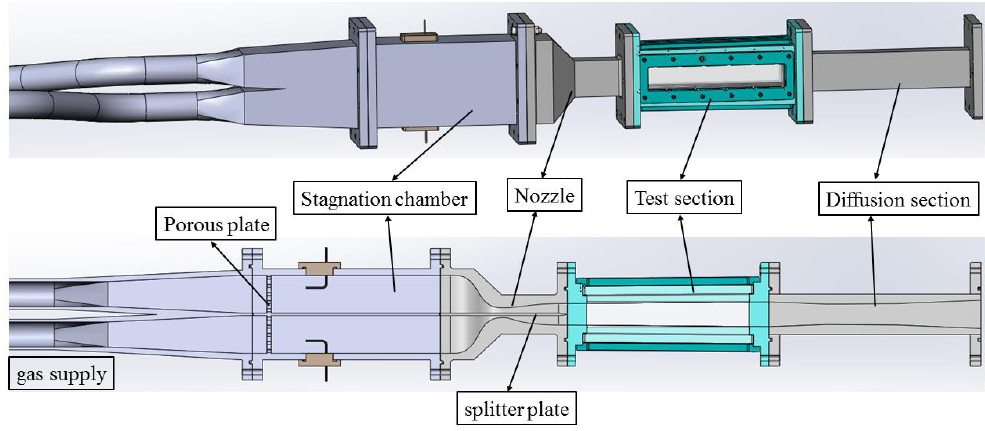
Figure 3. Structure of the wind